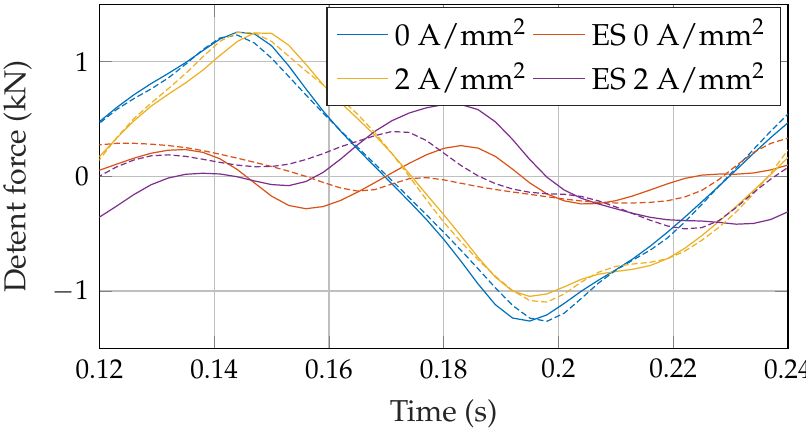
Figure 19. Detent force ripple for surface (solid) and buried (dashed), offset by the average value for the interval. The extended stator is indicated by orange and purple colors for both topologies. Blue and yellow colors indicate the stator without extension.